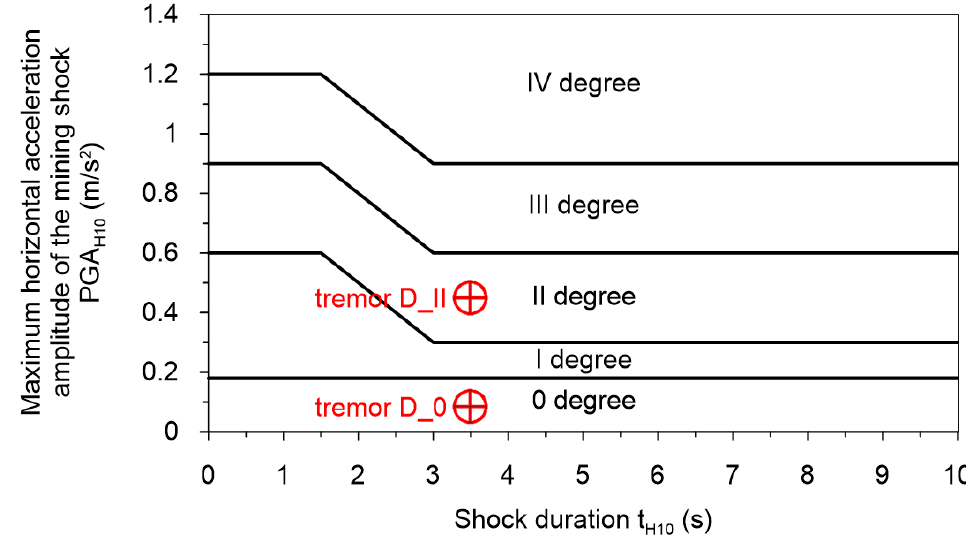
Figure 3. The degrees of the intensity of vibrations accordingly to the scale GSI-GZW KW-2012-A with intensities of the two analyzed tremors.